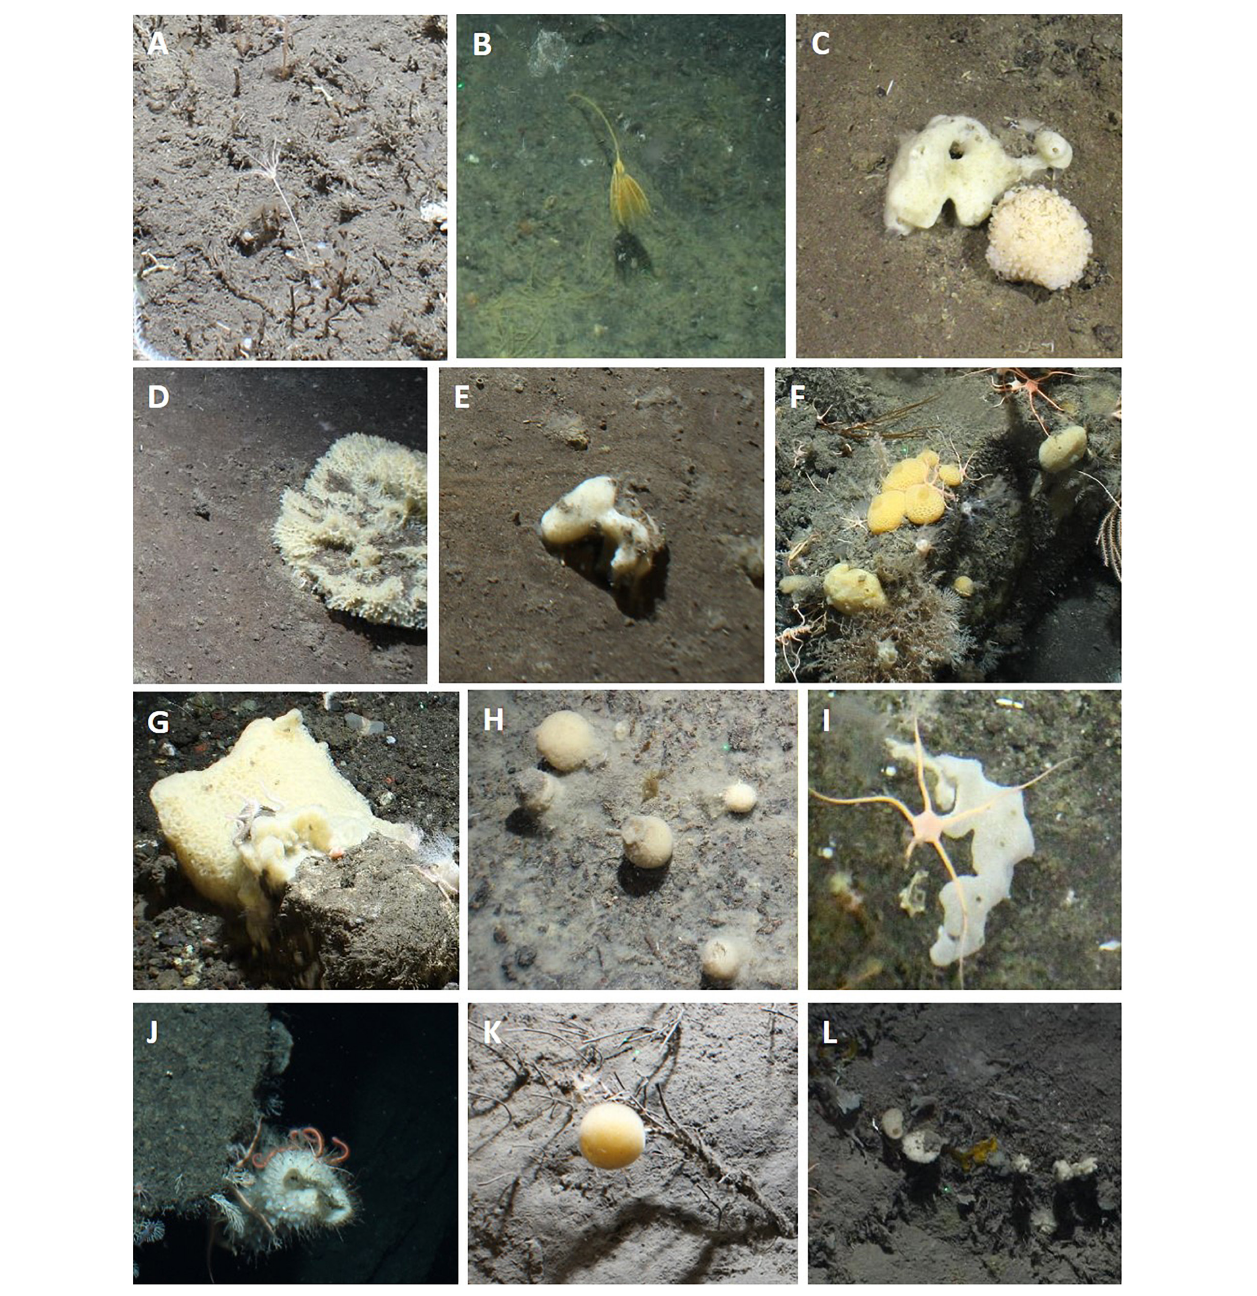
FIGURE 4 | Photographs showing examples of selected VME indicator taxa observed at the South Sandwich Islands. (A,B) stalked crinoids; (C–L)